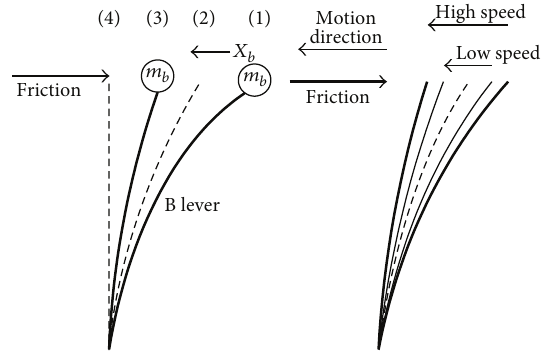
Figure 7: Illustrative representation of lever